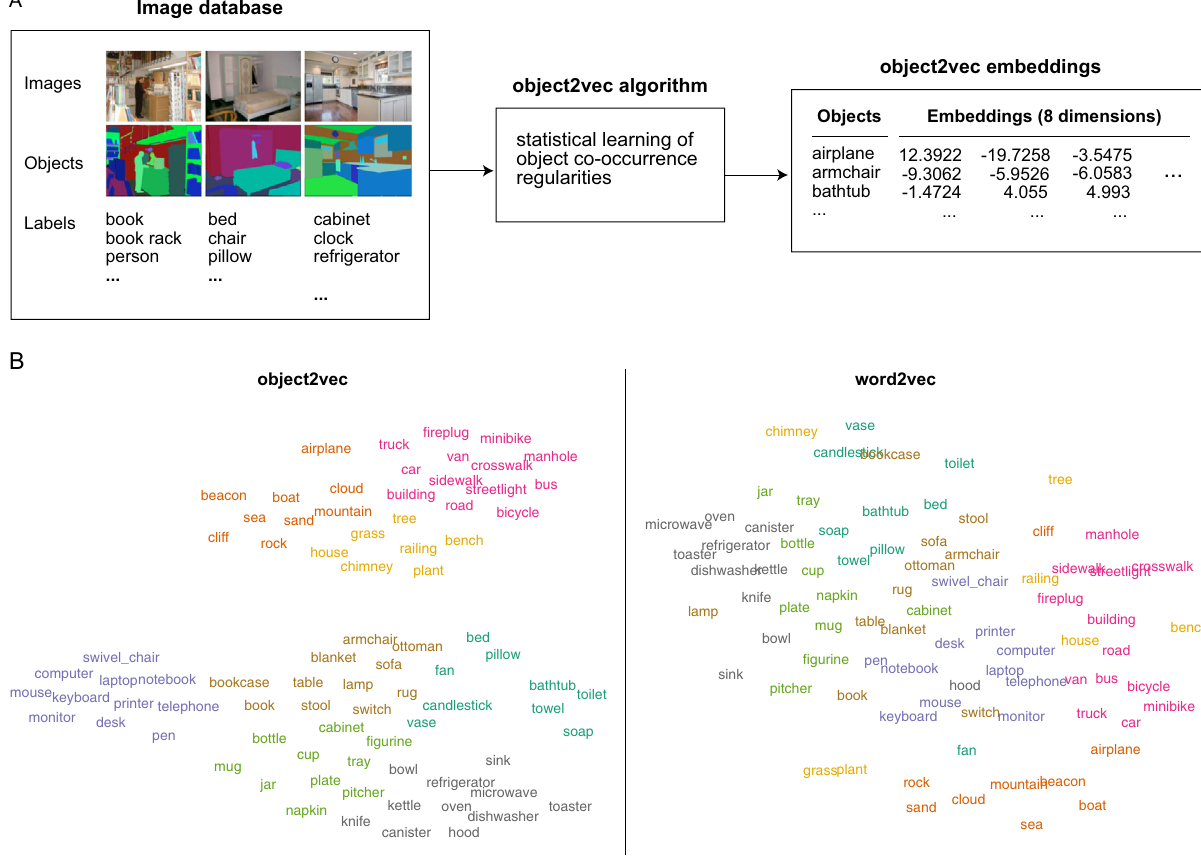
Fig. 1 Statistical model of visual object context. A Object context was modeled using the ADE20K data set 27 , which contains 22,210 images in which every pixel is associated with an object label provided by an expert human annotator. An adaptation of the word2vec machine-learning algorithm for distributional semantics — which we call object2vec — was applied to this corpus of image annotations to model the statistical regularities of object-label co- occurrence in a large sample of real-world scenes. Using this approach, we generated a set of 8-dimensional object2vec representations for the object labels in the ADE20K data set. These representations capture the co-occurrence statistics of objects in the visual environment, such that objects that occur in similar scene contexts will have similar object2vec representations. B The panel on the left shows a two-dimensional visualization of the object2vec representations for the 81 object categories in the fMRI experiment. This visualization shows that the object2vec representations contain information about the scene contexts in which objects are typically encountered (e.g., indoor vs. outdoor, urban vs. natural, kitchen vs. of fi ce). The panel on the right shows a similar plot for the language-based word2vec representations of the same object categories. These plots were created using t-distributed stochastic neighbor embedding (tSNE). The colors re fl ect cluster assignments from k-means clustering and are included for illustration purposes only. K-means clustering was performed on the tSNE embeddings for object2vec, and the same cluster assignments were applied to the word2vec embeddings in the right panel for comparison. Source data are provided as a Source Data fi